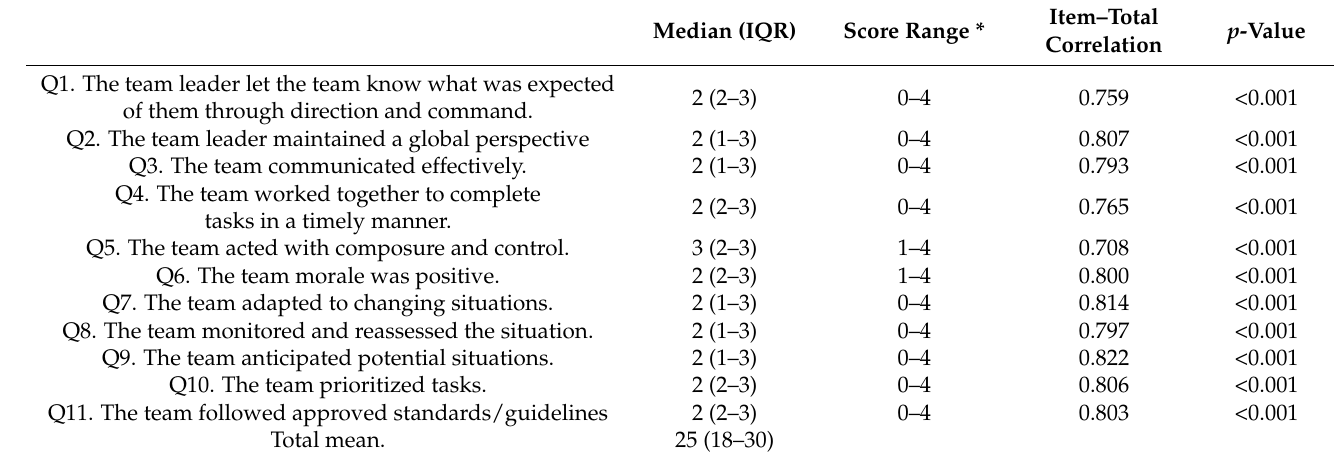
Table 3. The TEAM outcomes (67 clinical cases, 134 observations). Median (IQR) Score Range *